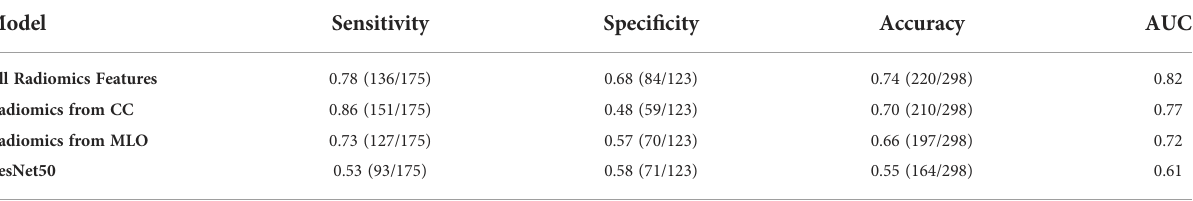
TABLE 3 The diagnostic performance of the radiomics models built using CC, MLO, and combined features, and deep learning model built using ResNet50. Model